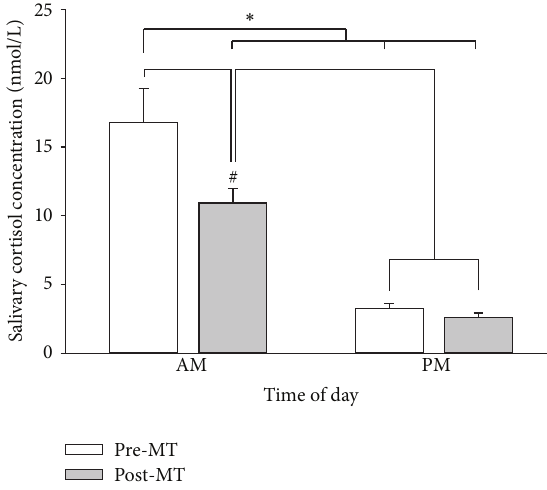
Figure 3: Increases in APB MEP amplitude after motor training are not influenced by time of day. Average ( 𝑛 = 10 ) APB MEP amplitude (mean ± SEM) recorded from 22 participants who participated in two experimental sessions: morning (AM) and evening (PM) on separate occasions. Average APB MEP amplitudes are shown before (pre-MT) and after (post-MT) motor training. APB MEP amplitude increased significantly following motor training, and this effect was independent of time of day.